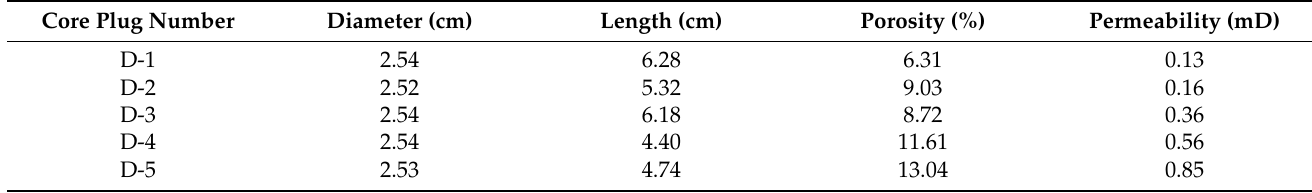
Table 2. The properties of the used core plugs in this work.